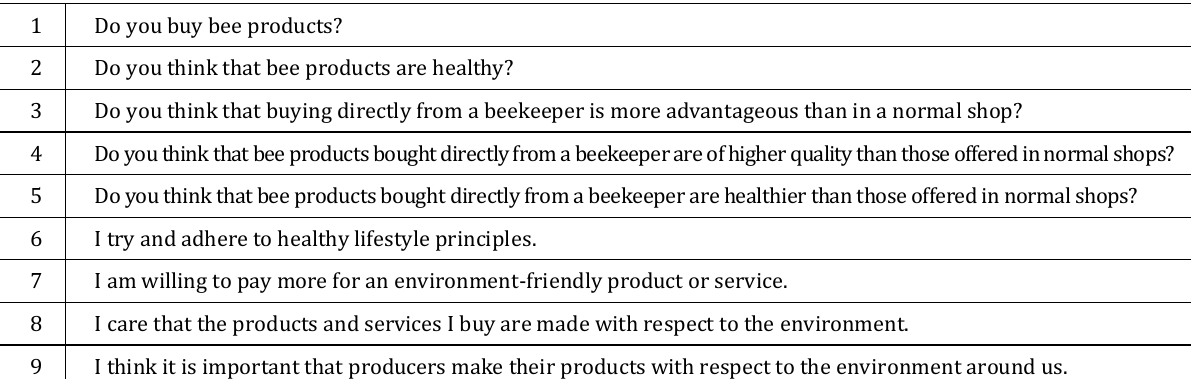
Table 1. List of dichotomous questions the respondents were asked